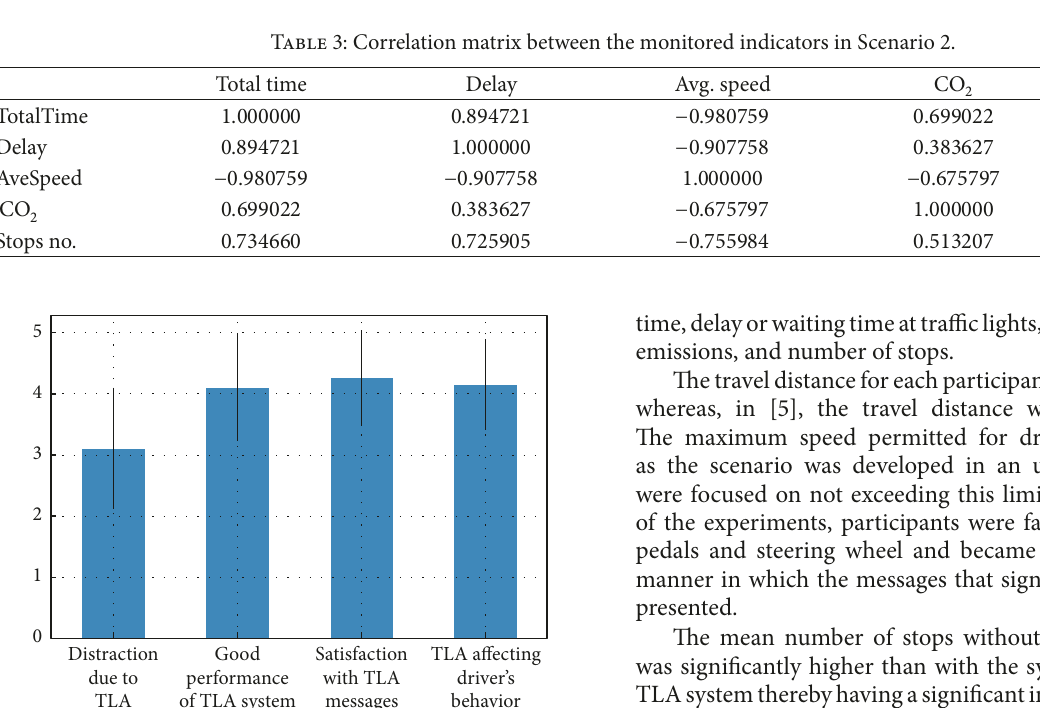
Figure 9: Ratings obtained from the qualitative